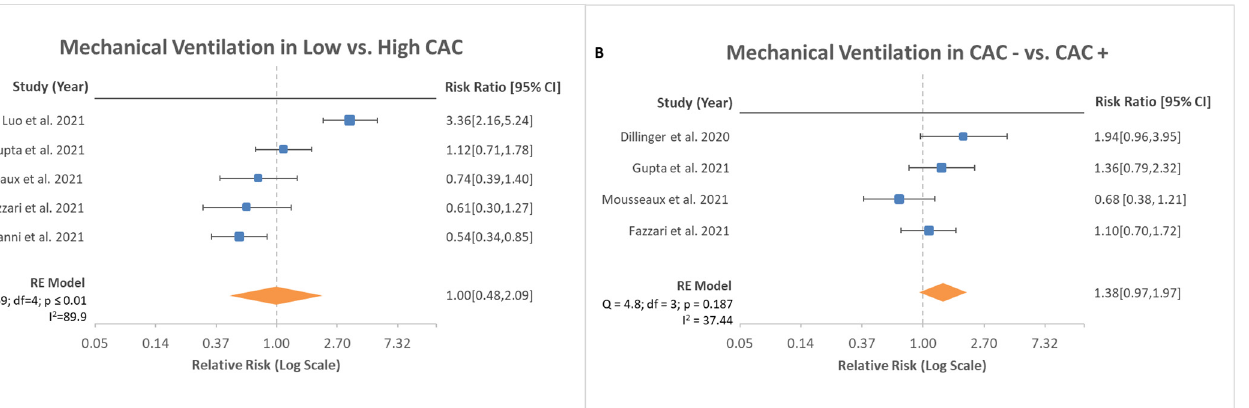
Figure 3. Risk ratio of mechanical ventilation based on stratification of CAC scores. ( A ) depicts risk in low CAC vs. high CAC with total of five studies analyzed with 95% confidence interval. Test for overall effect: Z = 0.00, p = 0.99. Test for overall effect: Z = 5.71, p < 0.00001. ( B ) depicts risk in absence of CAC vs. the presence of CAC with total of four studies analyzed with 95% confidence interval. Test for overall effect: Z = 0.72, p = 0.48.